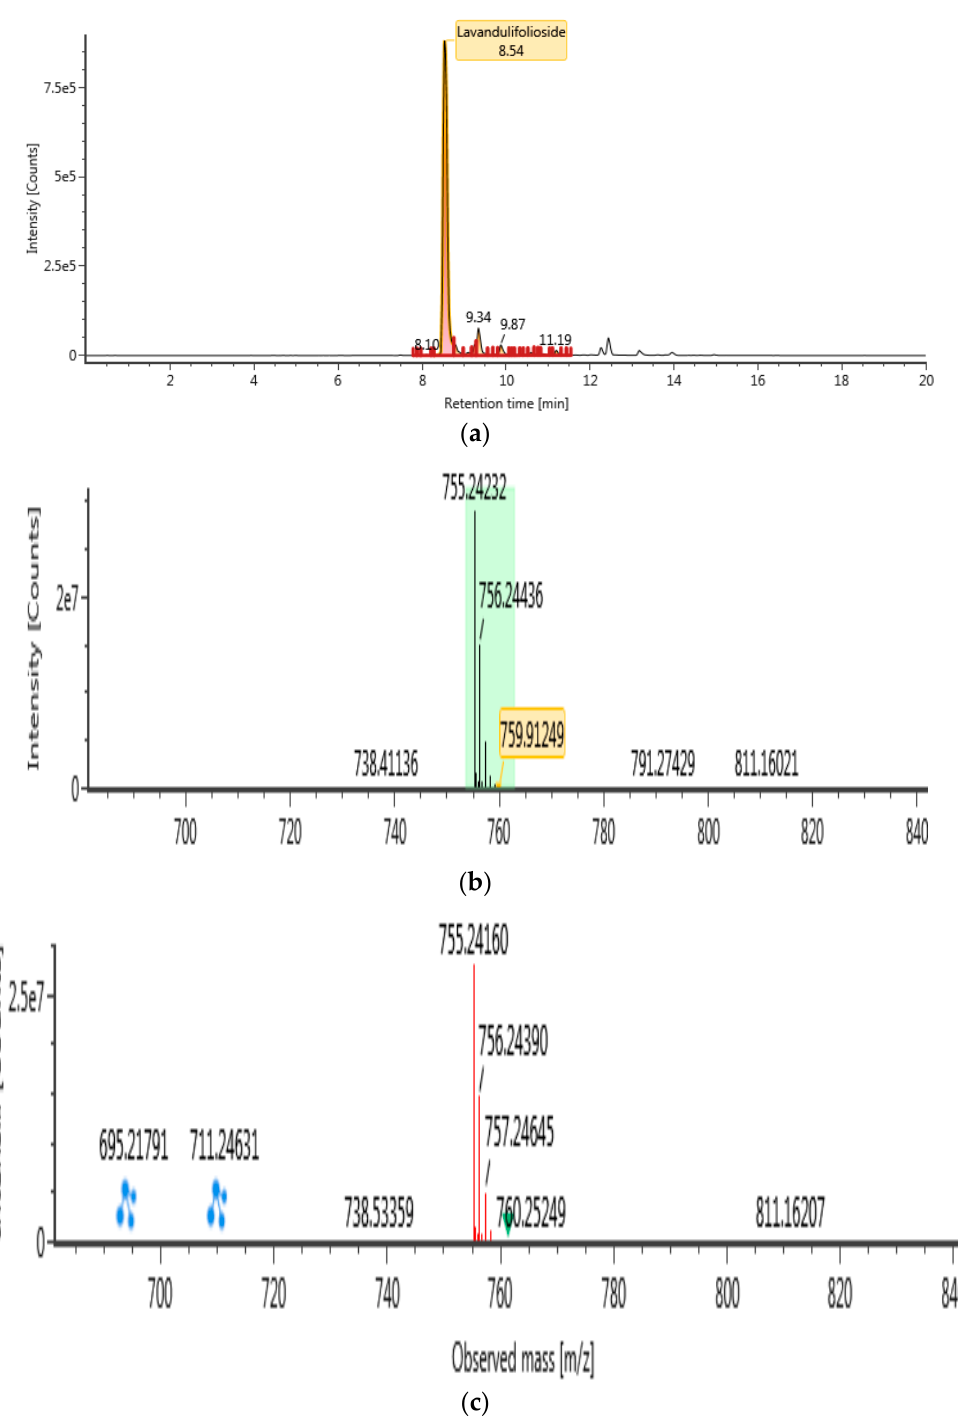
Figure 6. UHPLC ‐ QTOF/MS chromatograms of lavandulifolioside from Barleria lupulina Lindl. Figure 6. UHPLC-QTOF/MS chromatograms of lavandulifolioside from Barleria lupulina Lindl. extract (BLLE): ( a ) chro- extract (BLLE): ( a ) chromatogram mass spectrum; ( b ) low energy of mass spectrum; ( c ) high en ‐ matogram mass spectrum; ( b ) low energy of mass spectrum; ( c ) high energy of mass ergy of mass spectrum.